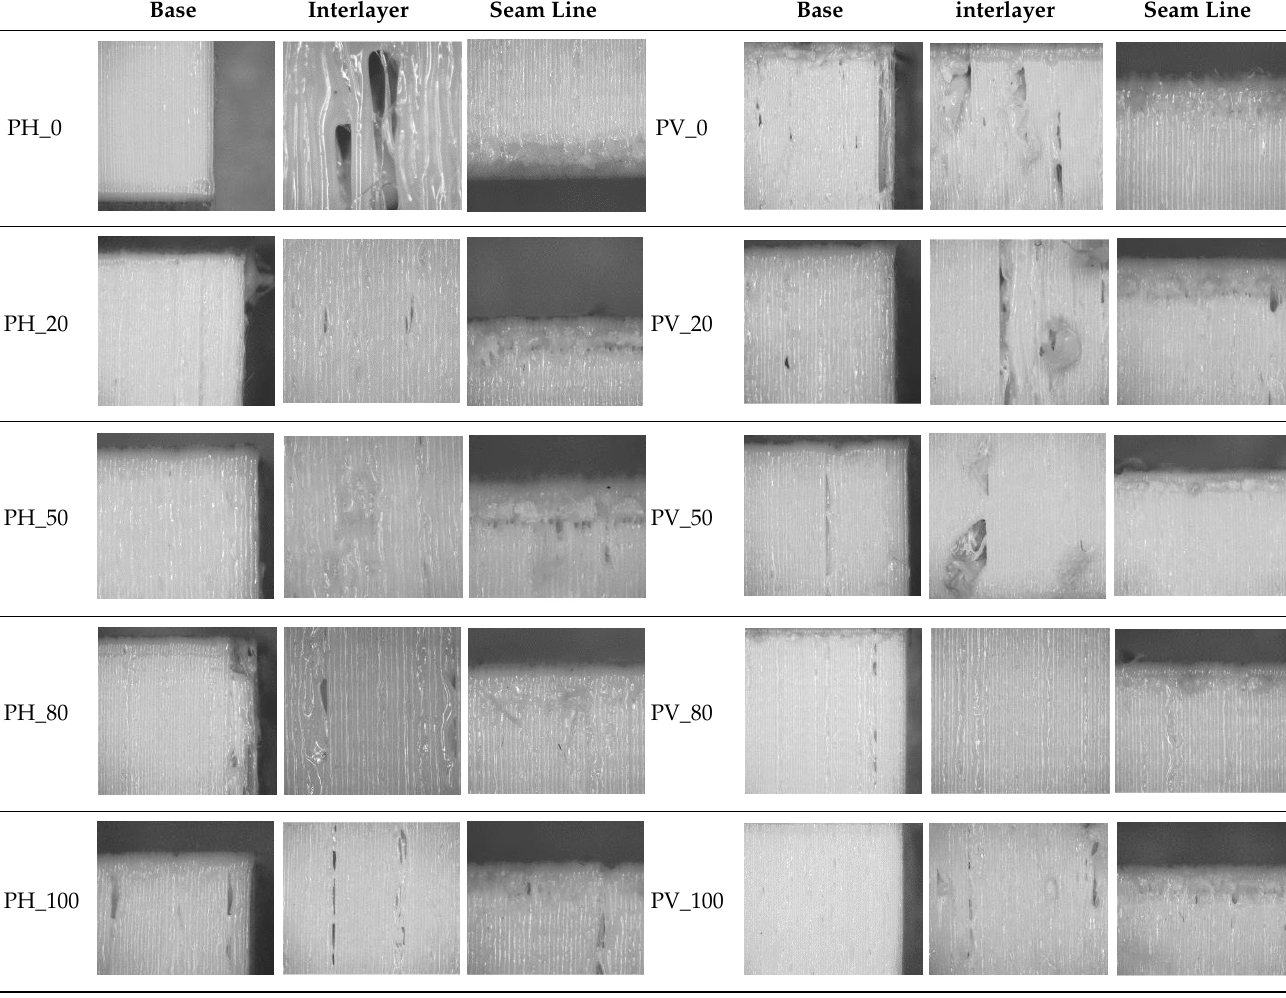
Table A2. Optic microscopy of cylinder specimens.